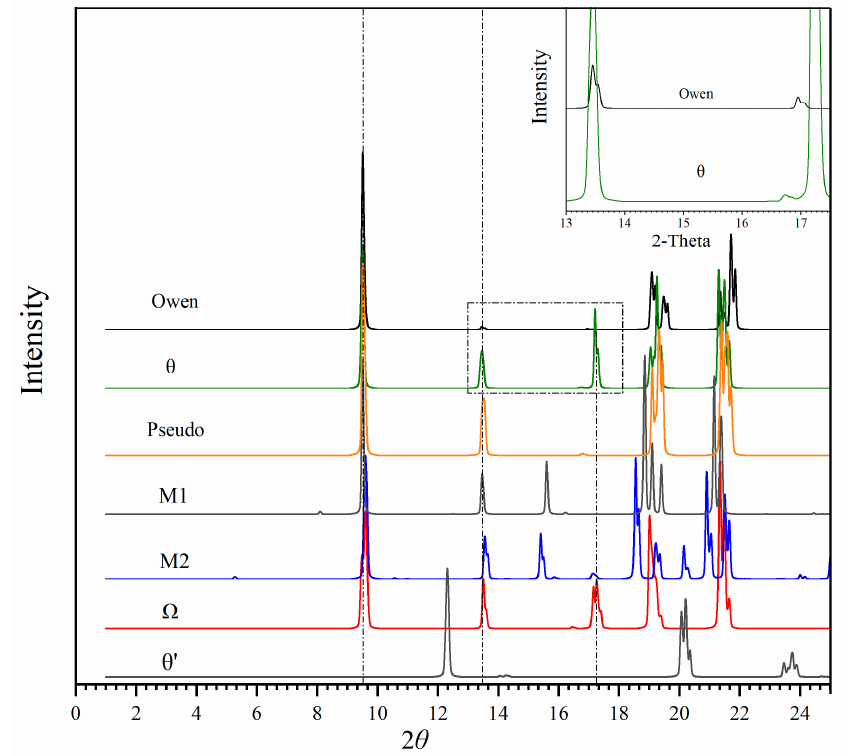
Figure 4. Simulated powder diffraction patterns for all existing and proposed Al 2 Cu phases. Table 1. Crystallographic information of all existing Al 2 Cu phases (the Owen-, θ -, θ ’- and Ω phase) and two proposed potential Al 2 Cu phases (M1 and M2 phase).